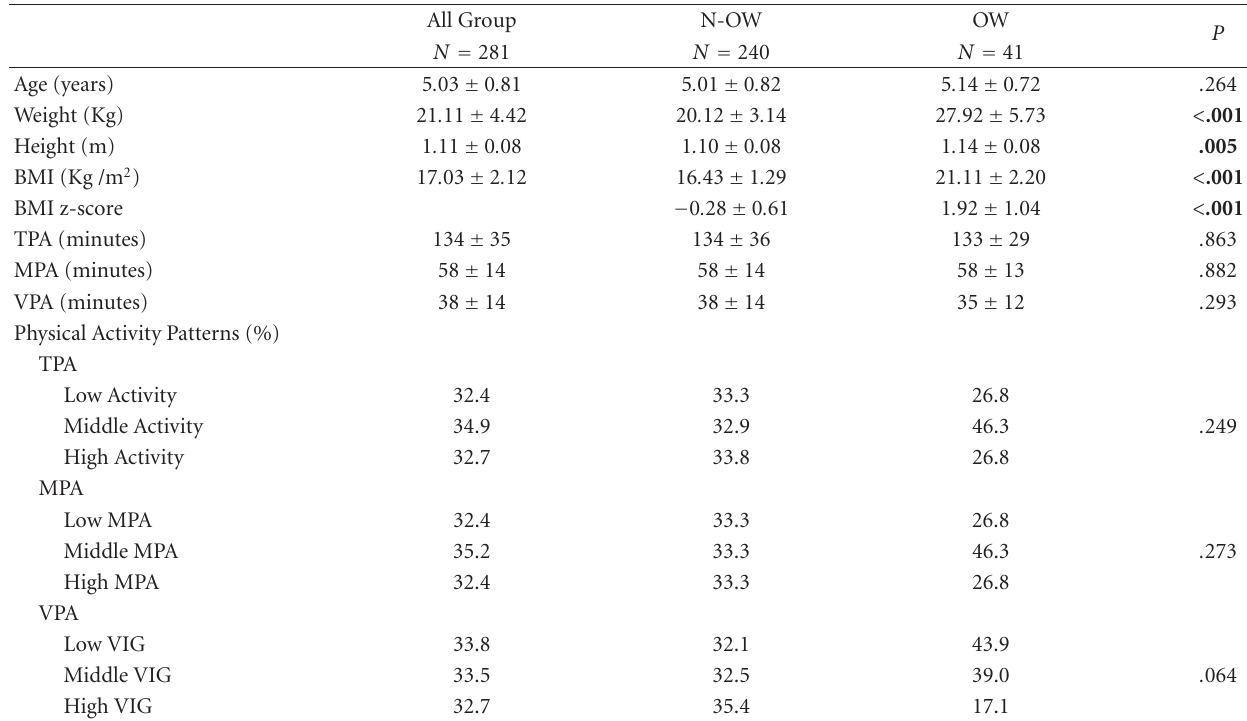
Table 1: Descriptive statistics of study